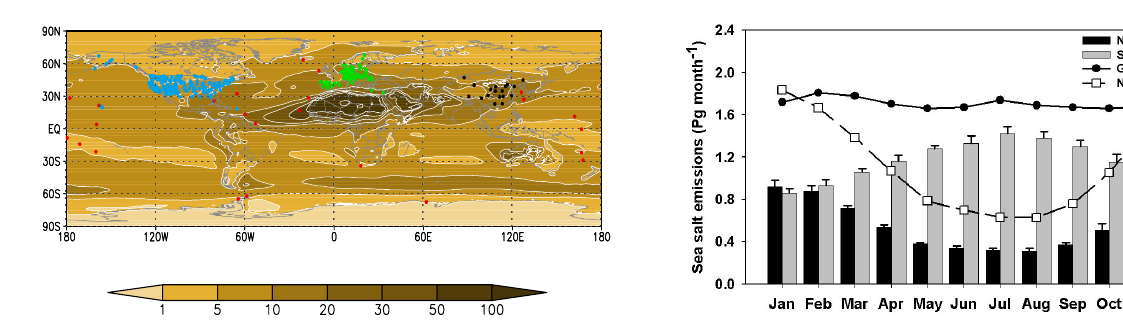
Fig. 1. Geographic locations of observational sites used in compar- ing with modeling results. The background contours are the PM 10 concentrations (µg m − 3 ) averaged from the ten years of modelled results. Blue dots are stations from IMPROVE and CAPMoN in North America, green dots are the stations from EMEP of Europe, black dots are stations from CAWNET of China and red dots are the stations from GAW and Miami University research stations.